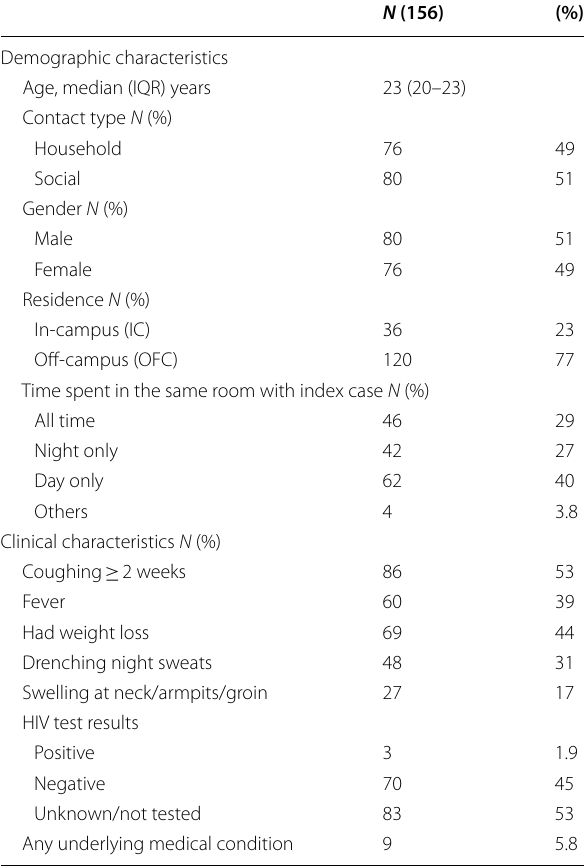
including screening strategies to identify and trace con- Table 2 Demographic and clinical characteristics of